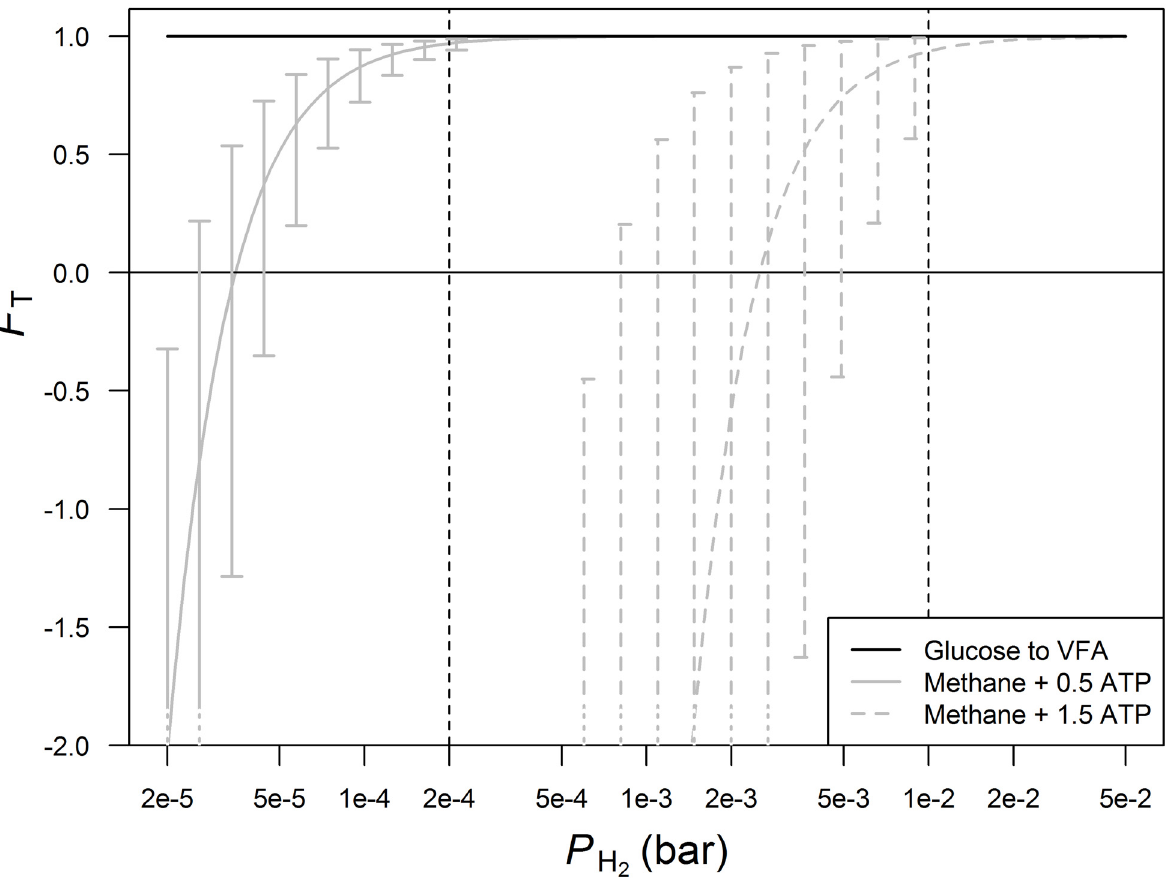
Fig 1. Thermodynamic potential factor ( F T ) as a function of P H for glucose fermentation pathways and methanogenesis. The 2 black line for glucose to VFA is valid for the reactions a to d (yielding acetate, propionate or butyrate), the solid and dotted gray lines represent methanogenesis with 0.5 and 1.5 mol of ATP per mol of CH 4 , respectively; a more detailed description of the glucose fermentation pathways to VFA and methanogenesis is given in Table 1. Confidence intervals represent uncertainty of F T to variation in . Vertical lines demarcate the rumen physiological range of P H . A log scale is used to plot the inputs other than P H 2 2